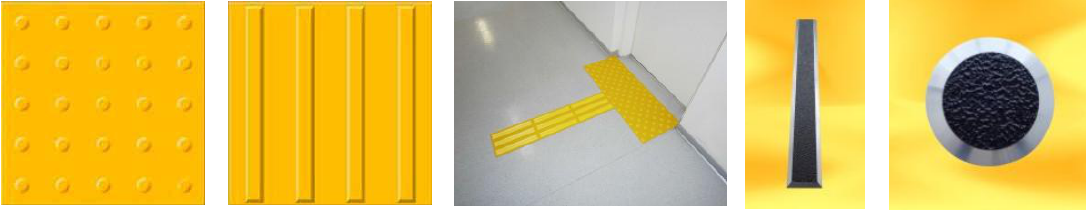
Figure 3. Two main patterns of TWSIs: “Attention” pattern and guiding” pattern.